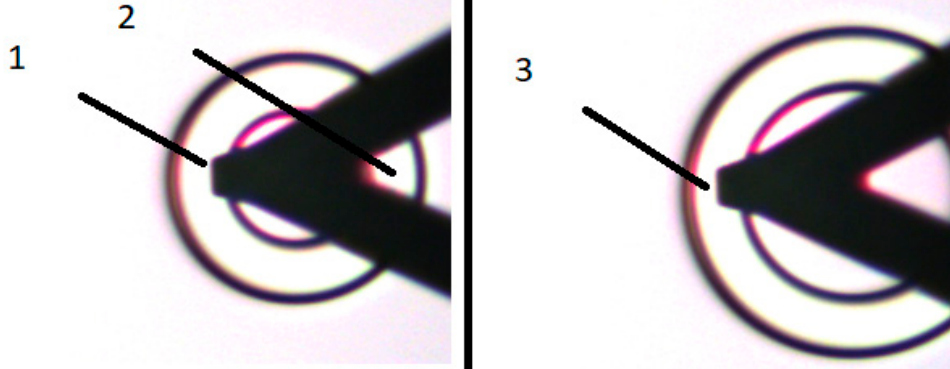
Figure 5. Scanned positions of the sample.